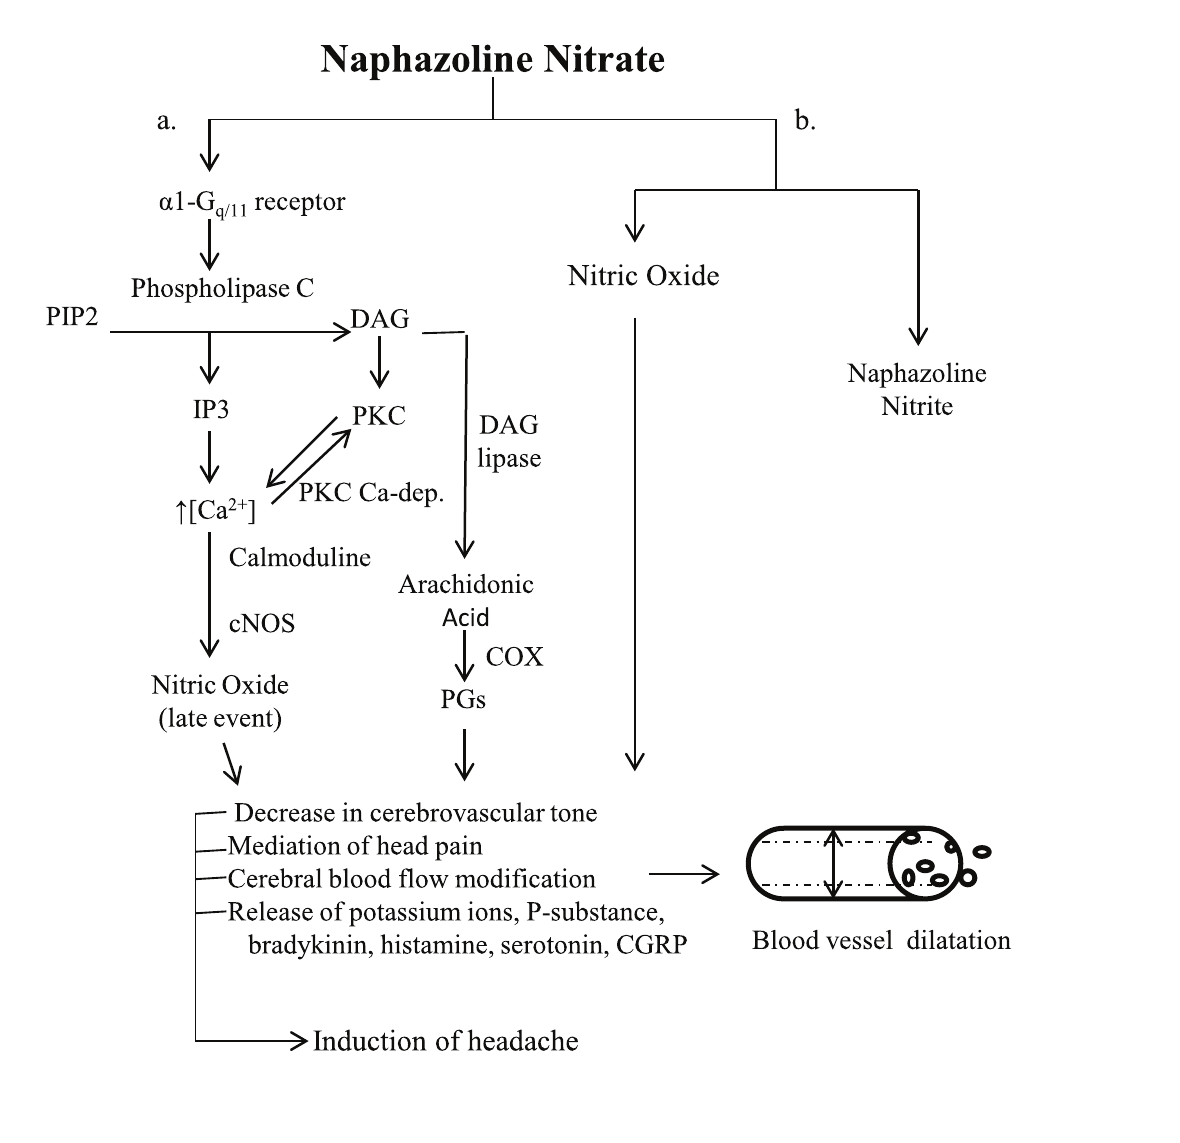
Figure 1. Late events induced by naphazoline that could cause headache. a . Naphazoline activates α 1 receptors that are associated with G-proteins that cause the activation of phospholipase C. Phospholipase C cleavesphosphatidyl-inositol 4,5-bisphosphate (PIP2) into two second messengers, inositol 1,4,5-trisphosphate (IP3) and diacylglycerol (DAG) which in turn cause an increase in the level of calcium and protein kinase C. Diacylglycerol, by DAG lipase, takes part in the creation of arachidonic acid which is a precursor in the production of prostaglandins (PGs), mediated by cyclooxygenase (COX). The higher concentration of intracellular calcium allows an increase in the complex of calcium-calmodulin and therefore the activation of constitutive nitrous oxide synthetase (cNOS) with the generation of nitric oxide 8,9 . b . Naphazoline nitrate can contribute to the production and release of further NO by a chemical reduction of the naphazoline salt. Prostaglandins and nitric oxide contribute to the activation of nociceptors and the transmission of the pain pulse from the periphery to the centre 10 . Consequently there is a release of substances such as potassium ions, P-substance, bradykinin, histamine, serotonin and CGRP that keep nociceptors active and result in vasodilatation and extravasation of plasma proteins from the